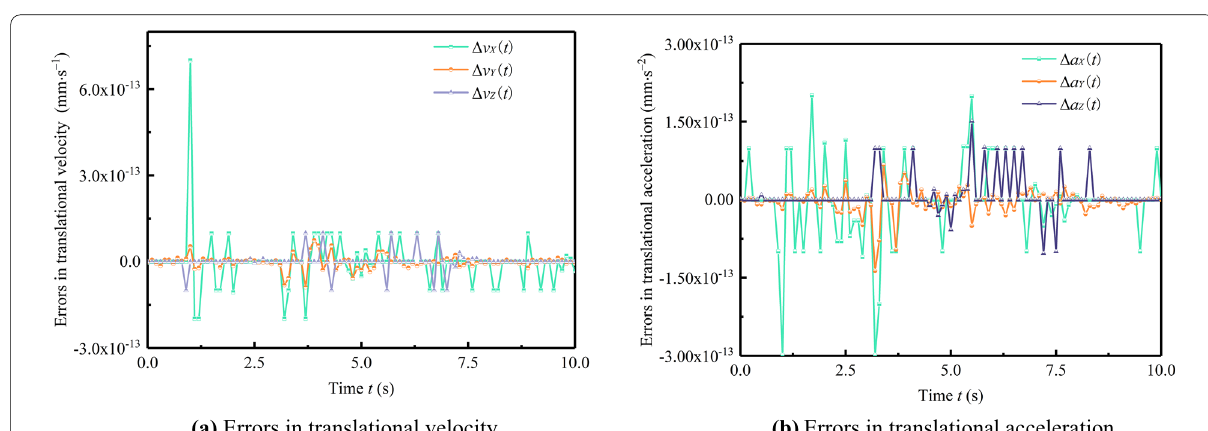
Figure 15 Translation of the end-moving platform